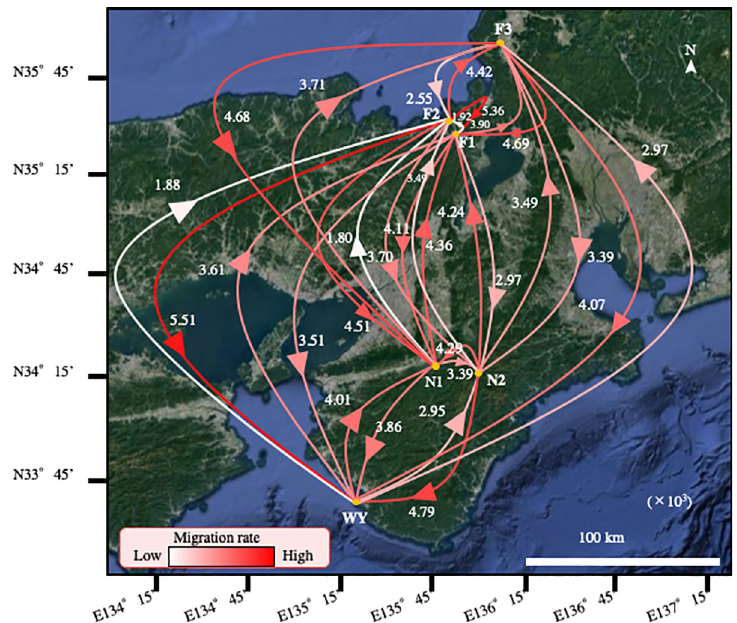
Fig 3. Gene flows among populations of M . fuliginosus bats in Japan (Wakayama, Nara, Fukui prefecture). The gene flows were estimated based on the D-loop amplicon sequencing results and subsequent analysis with Migrate-n software. The arrowheads on the lines show the directions of gene flow and the numbers near the arrowheads are the relative values of the gene flows ( × 10 3 ).